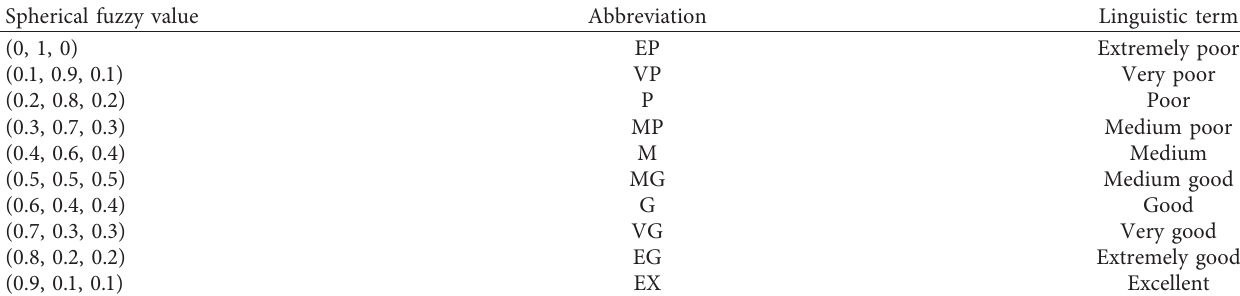
Table 1: Linguistic terms and corresponding spherical fuzzy